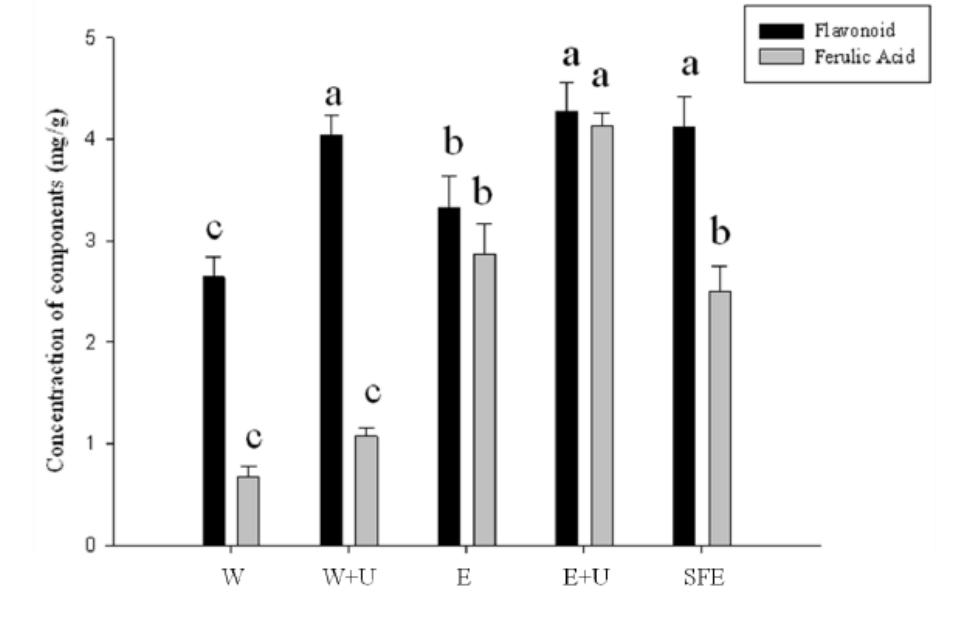
Figure 1. Comparison of the five extraction methods for obtaining flavonoids and